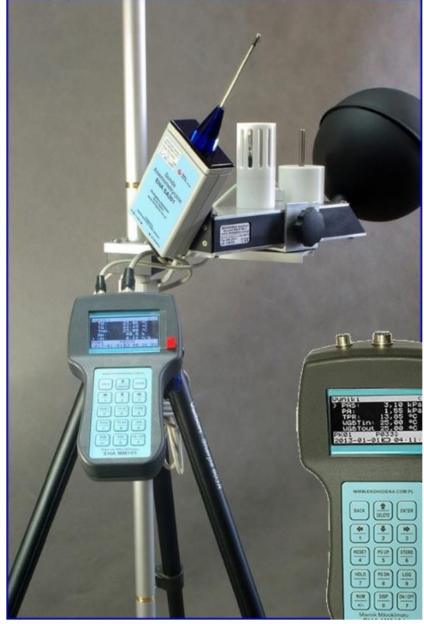
Figure 1. The photo of microclimate meter [26].